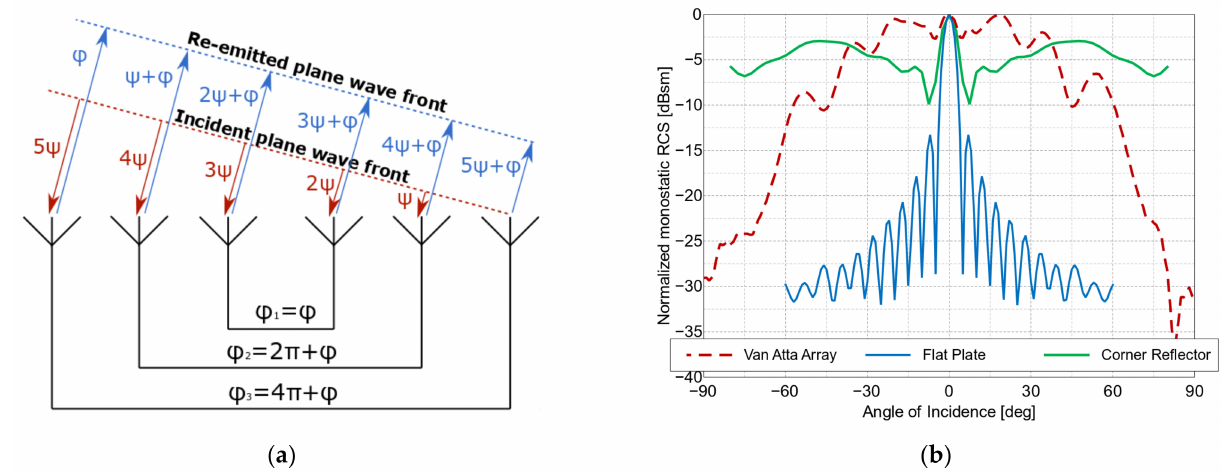
Figure 2. The Van Atta array: ( a ) schematic of the operation principle; ( b ) comparison of the RCS values of a Van Atta array (20 mm × 18 mm), those of a flat metal plate (23 mm × 29 mm), and those of a corner reflector (12 mm × 12 mm × 12 mm), all at a frequency of 62 GHz. The re-radiated wave can be of the same polarization as the incident wave in the case of a co-polarized array. In the case of a cross-polarized array, the polarization of the re-emitted wave is orthogonal to the received wave. The key feature of Van Atta arrays is their wide angular range of almost uniform reflection characteristics. This property can be seen in Figure 2b, where the RCS values of an example co-polarized Van Atta array of 20 mm × 18 mm size are compared to the RCS values of a flat plate with dimensions of 23 mm × 29 mm and a 3D corner reflector with a side length of 12 mm. The Van Atta array’s RCS characteristics are more uniform in the − 45 ◦ to 45 ◦ range of interrogation angles compared to the standard corner reflector, but this falls off quickly for the angles further from the main axis, whereas the corner reflector has a high RCS value for the angles close to the parallel incidence ( − 90 ◦ and 90 ◦ ). Because the strictly defined phase shifts are realized by transmission lines, Van Atta arrays maintain their retrodirective properties only in a narrow band near the resonance frequency. Although usually considered a drawback, this feature can be turned into an advantage, as it provides the means to construct a simple chipless RFID tag out of a single Van Atta array, with a unique resonance frequency serving as the tag’s identifier. The design of both co- and cross-polarized Van Atta arrays is presented in the paper, and three tags of each type were designed with different resonance frequencies as their distinguishing features. The tags were manufactured using PCB technology on a 0.127 mm thick ROGERS RT/duroid 5880 substrate ( ε r = 2.20 and tan δ =